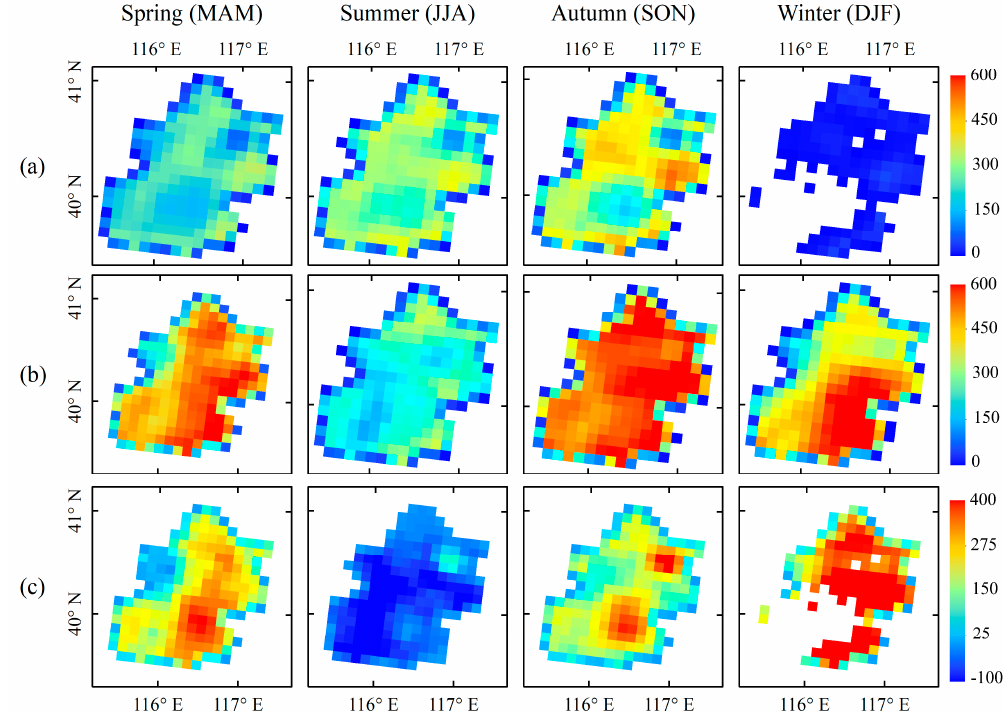
Figure 5. The number of days for the effective retrieval (NE) of ( a ) MODIS-Terra C6.1 DT and ( b ) MODIS-Terra C6.1 DB; and ( c ) the seasonal number differences (DB_NE – DT_NE) between the DT and DB from January 2001 to December 2016.